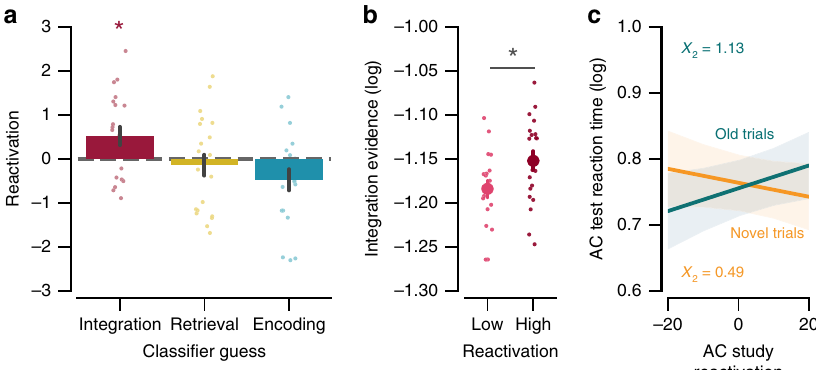
Fig. 5 Relationship between reactivation and integration. a Signi fi cant reactivation of old memories was observed only on trials for which the mnemonic state classi fi er guessed “ integration ” ( p = 0.025). Each dot represents data from an individual subject. b High reactivation trials were associated with greater integration evidence compared to low reactivation trials ( p = 0.048). Each dot represents data from an individual subject. c There were no signi fi cant relationships between reactivation during AC Study and reaction times during AC Test for either the Old or Novel conditions. Shaded regions re fl ect 68% con fi dence interval. Notes: Error bars re fl ect s.e.m.; * p < 0.05 by t